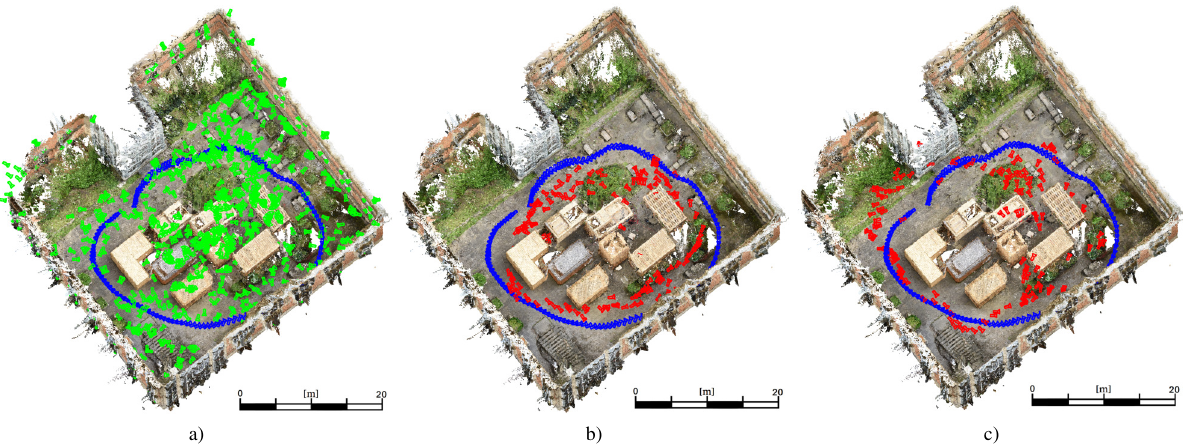
Figure 6. Atrium data set, medium coverage sequence . a) Visualization of ground truth, b) results derived by the CNN adaptation of VGG16-Net, c) results derived by SqueezePoseNet. Green cameras indicate training data, blue cameras depict the ground truth and red cameras are estimated poses derived by the modified CNNs.